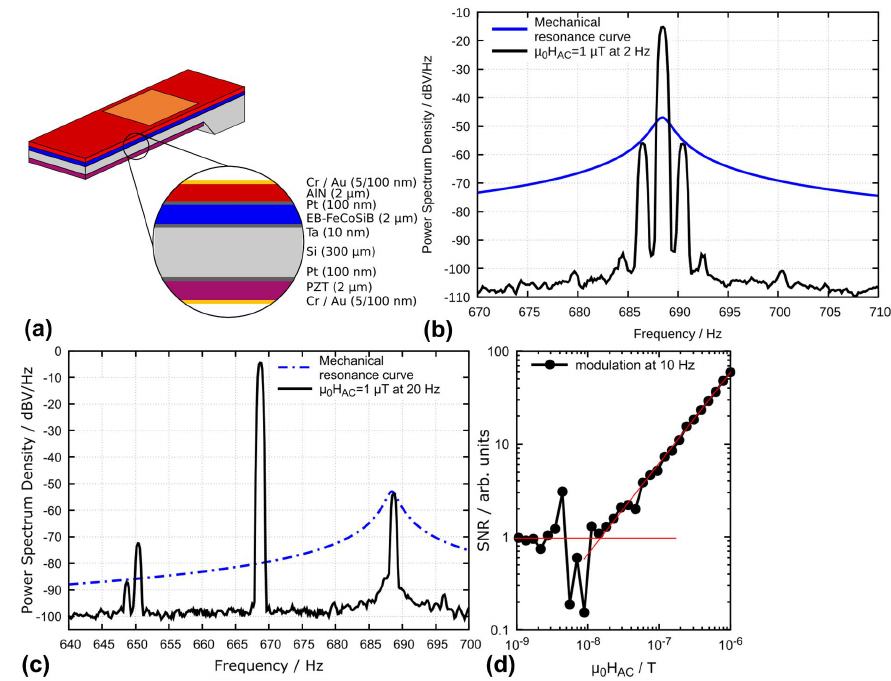
Figure 4. ( a ) Schematic of the cantilever-type magnetometer using electric frequency